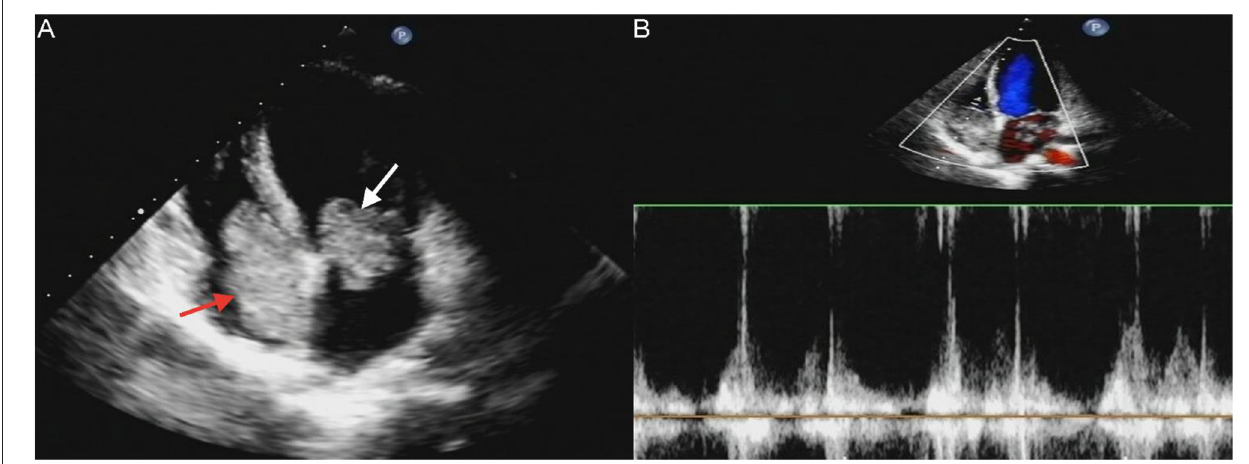
FIGURE 2 | Transthoracic echocardiography (TTE) revealed masses attached to the atrial septum in the left atrial cavity (white arrow) and the right atrial cavity (red arrow) (A) . Acceleration of tricuspid valves antegrade flow (B) .